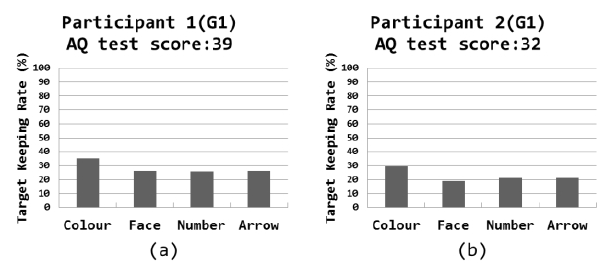
Figure 7. TKR of the participants in Group 1 (Autism). (a) Participant 1(G1): Male, AQ score: 39, (b) Participant 2(G1): Male, AQ score: 32.